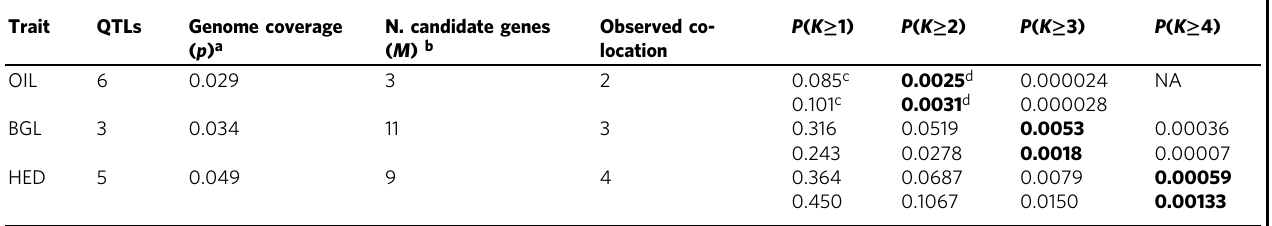
Table 2 Probability of observing at least K QTL co-located with candidate